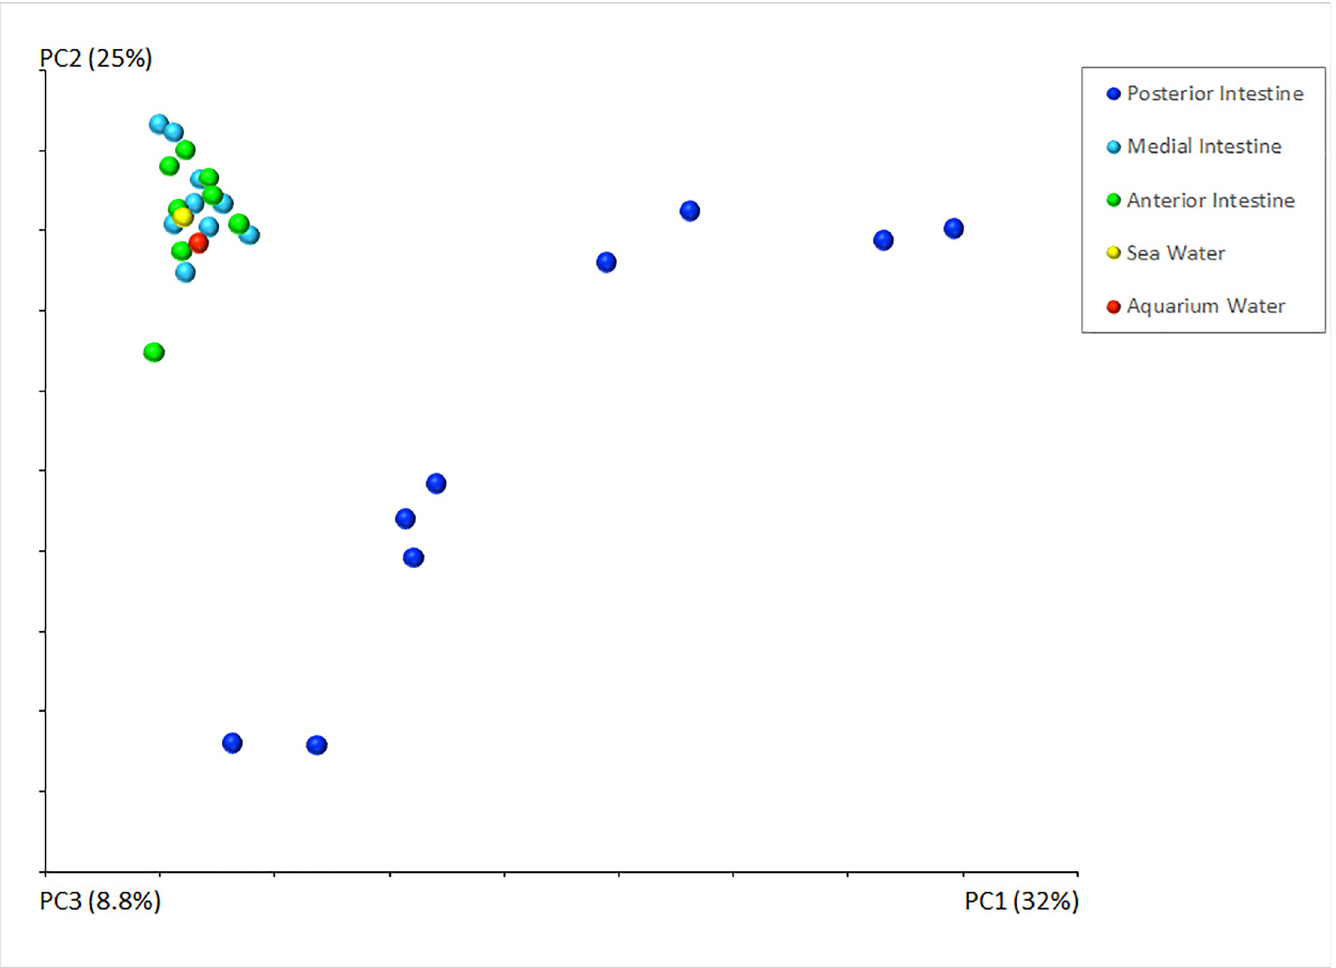
Fig 3. Principal Coordinate Analyses (PcoA) of bacterial communities in the intestine of H . glaberrima . Samples clustered using PcoA of weighted UniFrac distance matrices that reflect the beta-diversity of the bacterial communities. The graph shows the UniFrac distance of bacterial communities from the anterior, medial and posterior intestine of the sea cucumber H . glaberrima